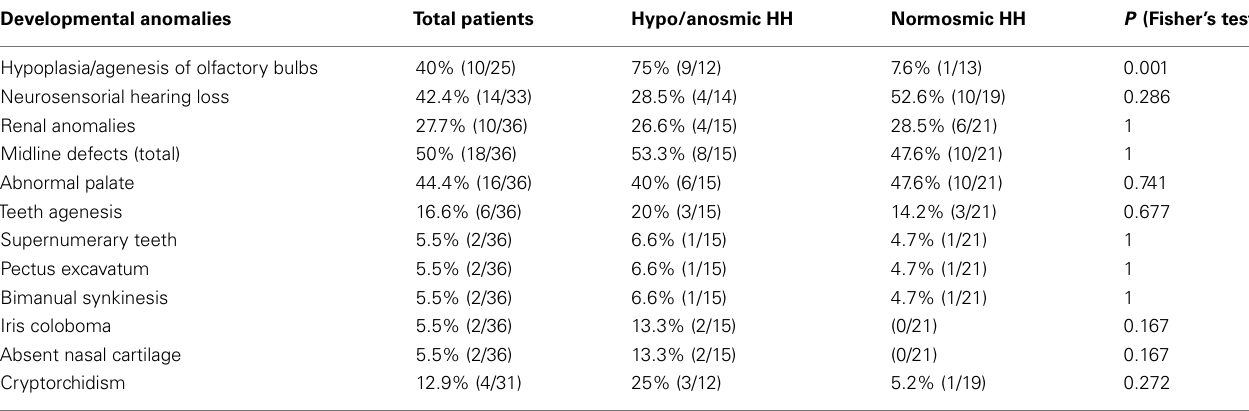
Table 1 | Percentages of developmental anomalies in HH